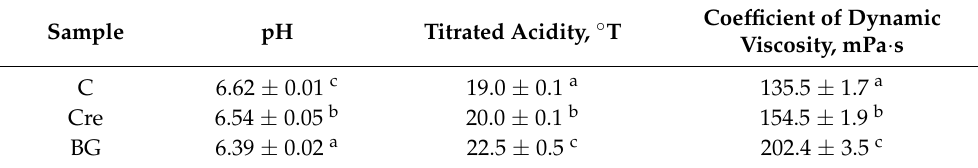
Table 1. Acidity of ice cream samples and coefficient of dynamic viscosity of ice cream mixes. Sample